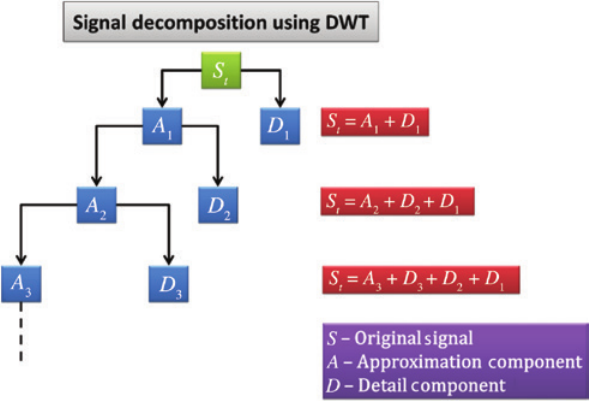
Figure 4: Signal Decomposition by DWT for Three Resolution Levels.